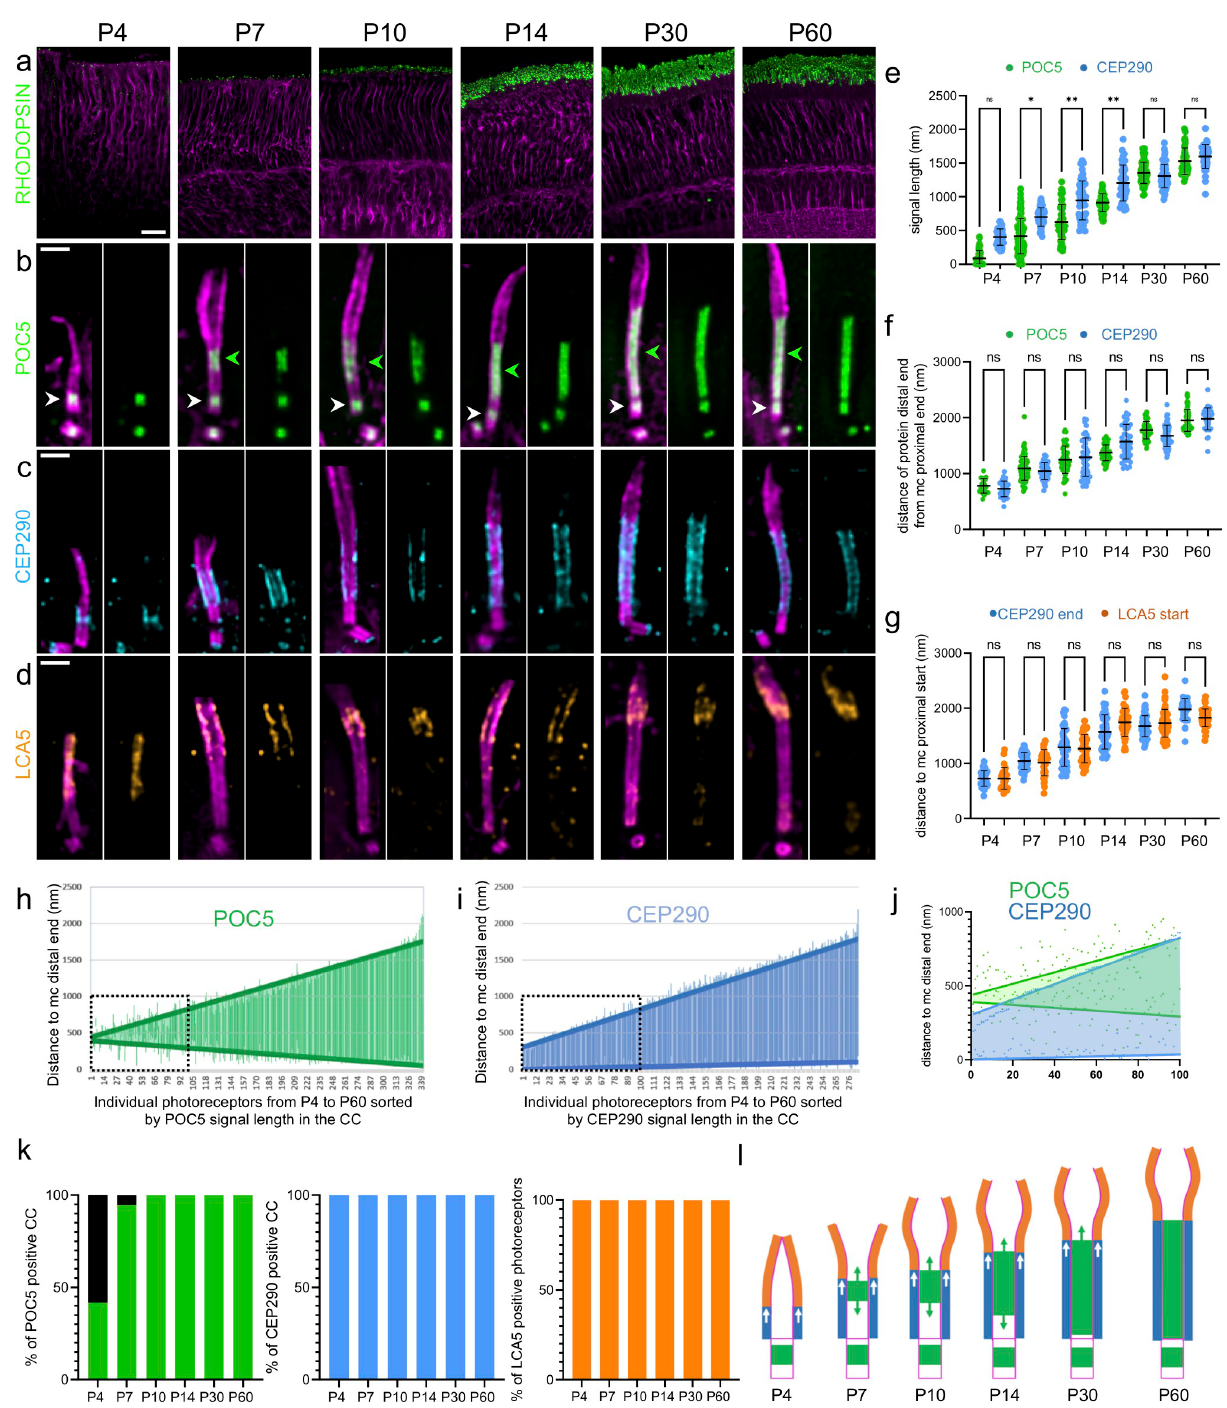
Fig 2. Photoreceptor CC inner scaffold assembly. ( a ) Low magnification of expanded retinas showing rod OS formation from P4 to P60 stained with RHODOPSIN (green) and tubulin (magenta). Scale bar: 20 μ m. ( b–d) Expanded photoreceptors stained for tubulin (magenta) and POC5 (green, b), CEP290 (cyan, c), or LCA5 (orange, d) from P4 to P60. Note that CEP290 also caps the daughter centriole. Green arrowheads = CC inner scaffold; white arrowheads = centriole inner scaffold. Scale bar: 500 nm. ( e ) Quantification of POC5 (green) and CEP290 (cyan) signal length inside the CC over time; � 3 animals per time point. ( f ) Quantification of the distance of POC5 (green) and CEP290 (cyan) signal distal ends in the CC to the mother centriole proximal end from P4 to P60; � 3 animals per time point. ( g ) Distance of CEP290 signal distal end (cyan) and LCA5 signal start (orange) to the mother centriole proximal end; � 3 animals per time point. Note that CEP290 measurements are the same as in (f). ( h, i ) Length and position of POC5 (h: green) or CEP290 (i: cyan) signal within the CC. Note that signals are sorted by length and distances are compared to MC distal end (measurements from P4 to